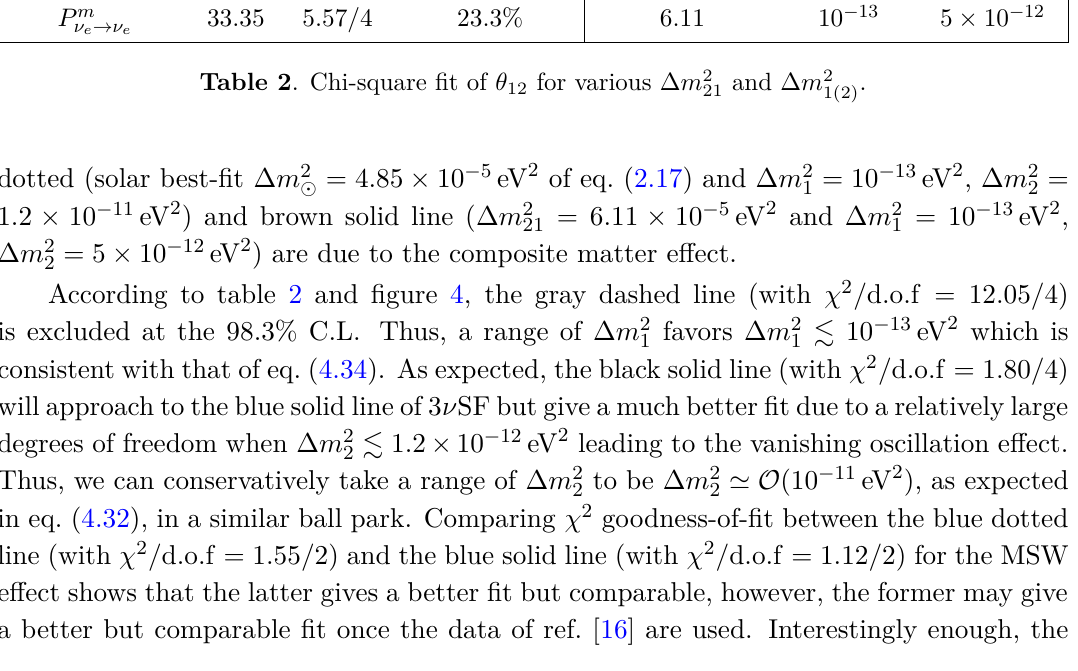
Table 2 . Chi-square fit of θ 12 for various ∆ m 2